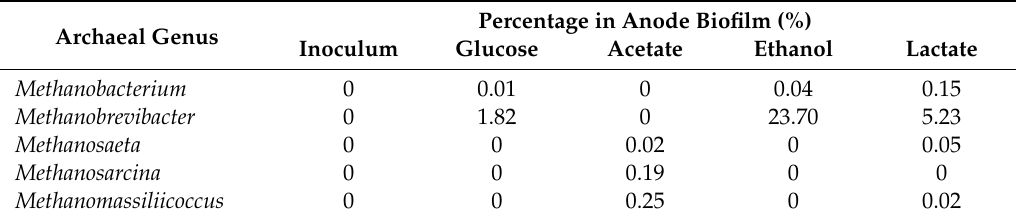
Table 2. The ratio of archaea species in the bioelectroactive biofilms enriched with di ff erent energy